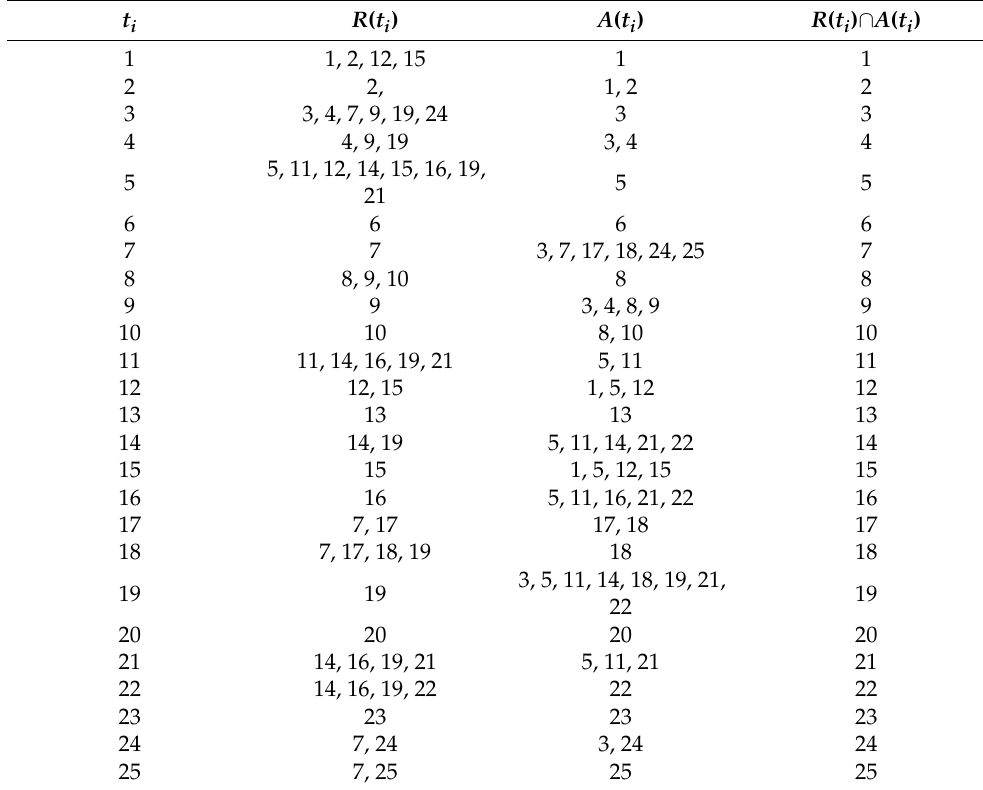
Table 8. The result of reachable set and antecedent